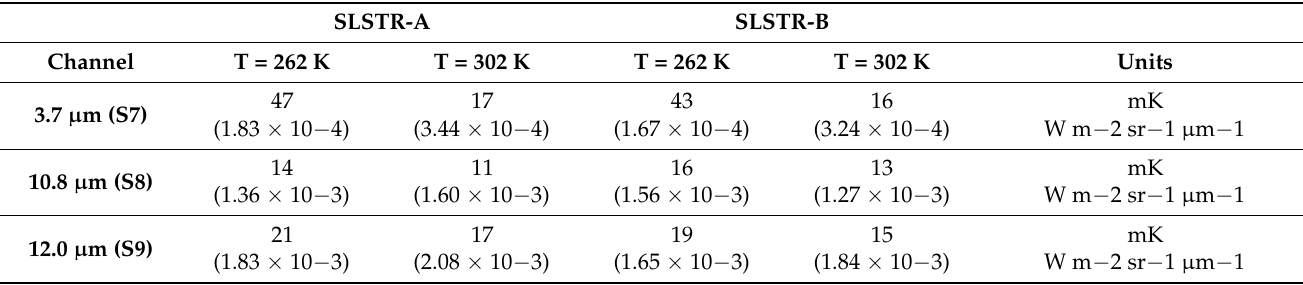
Table 3. Average on-orbit NEDT estimates (and noise in radiance) for SLSTR-A and B derived from in-flight blackbody measurements.